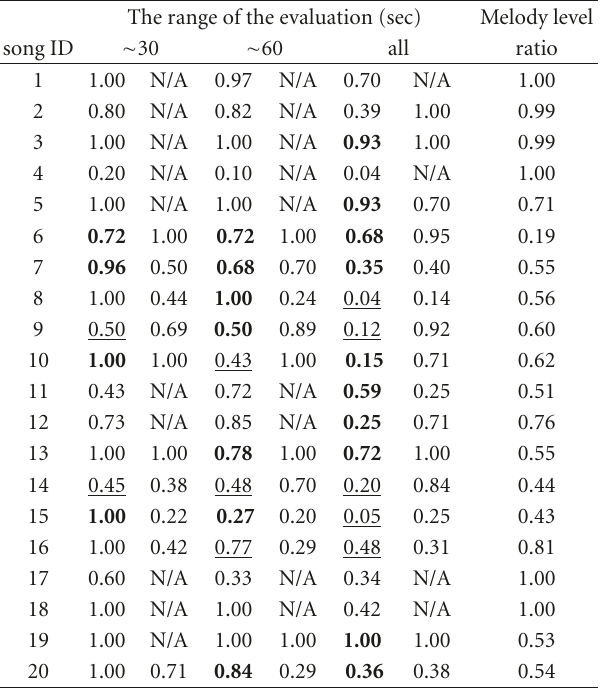
Table 4: Score following error ratio w/ level switching. Left: melody level accuracy, | e pred ( t ) | < 1 (sec). Right: rhythm level accuracy,